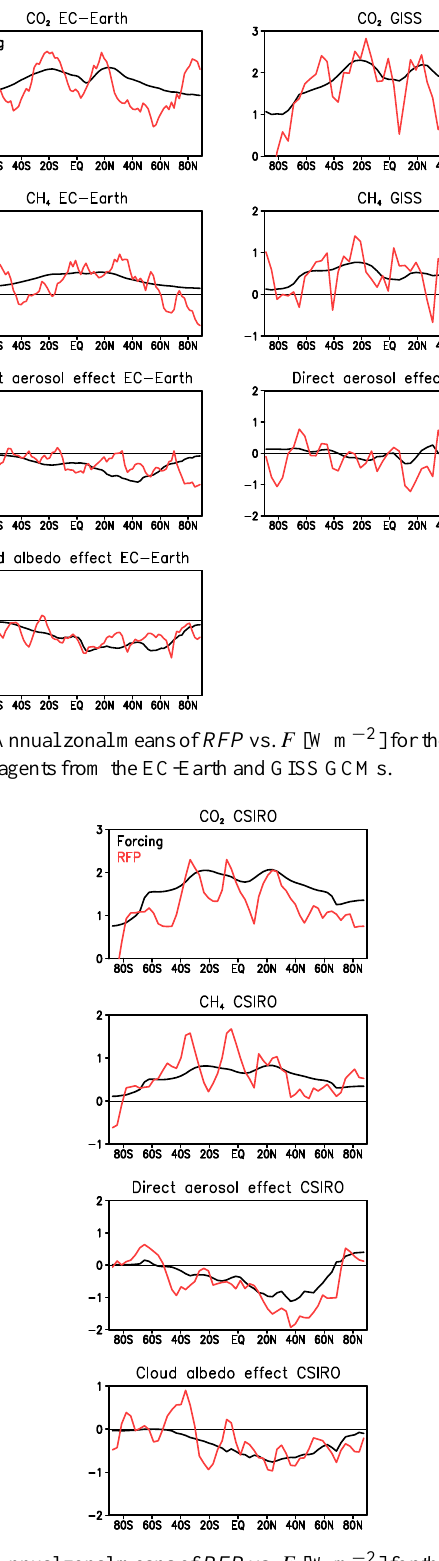
Fig. 6. Annual zonal means of RFP vs. F [Wm − 2 ] for the different forcing agents from the CSIRO GCM.